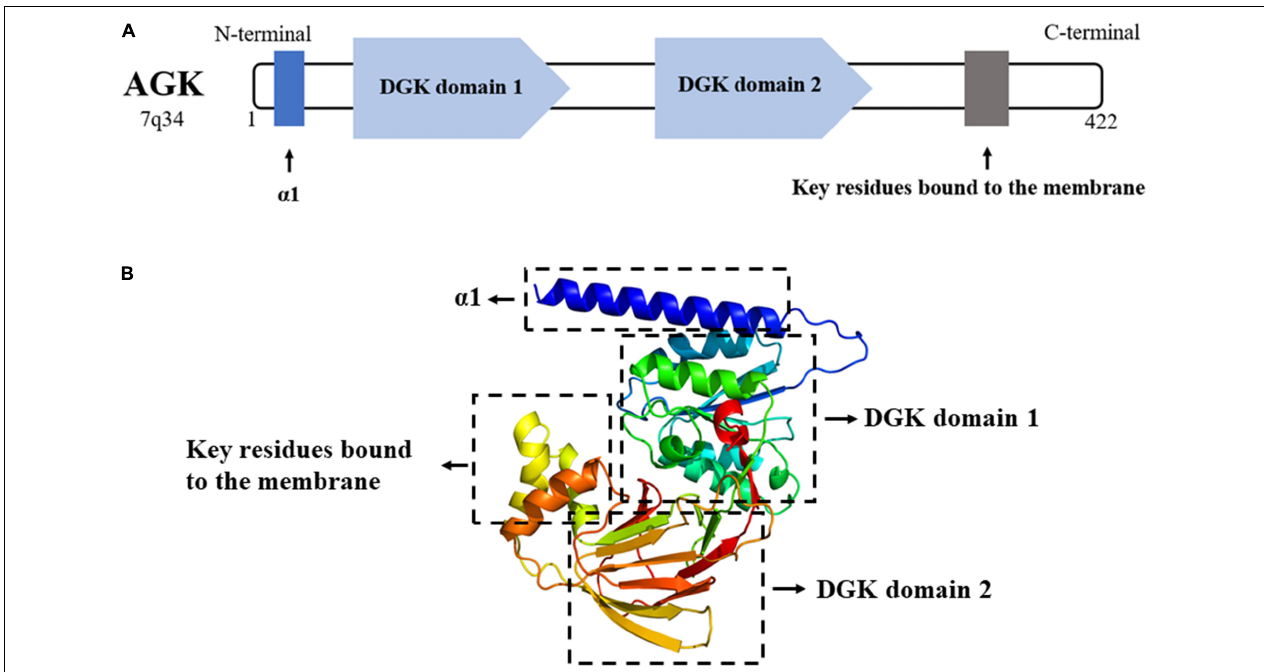
FIGURE 2 | (A) AGK is composed of 422 amino acids and contains an α 1 helix, a DGK domain 1, a DGK domain 2, and a C-terminal key residue bound to the membrane. DGK, diacylglycerol kinase. (B) 3D structure of AGK generated by X-ray crystal diffraction and visualized in Phyre2 (Kelley et al., 2015).